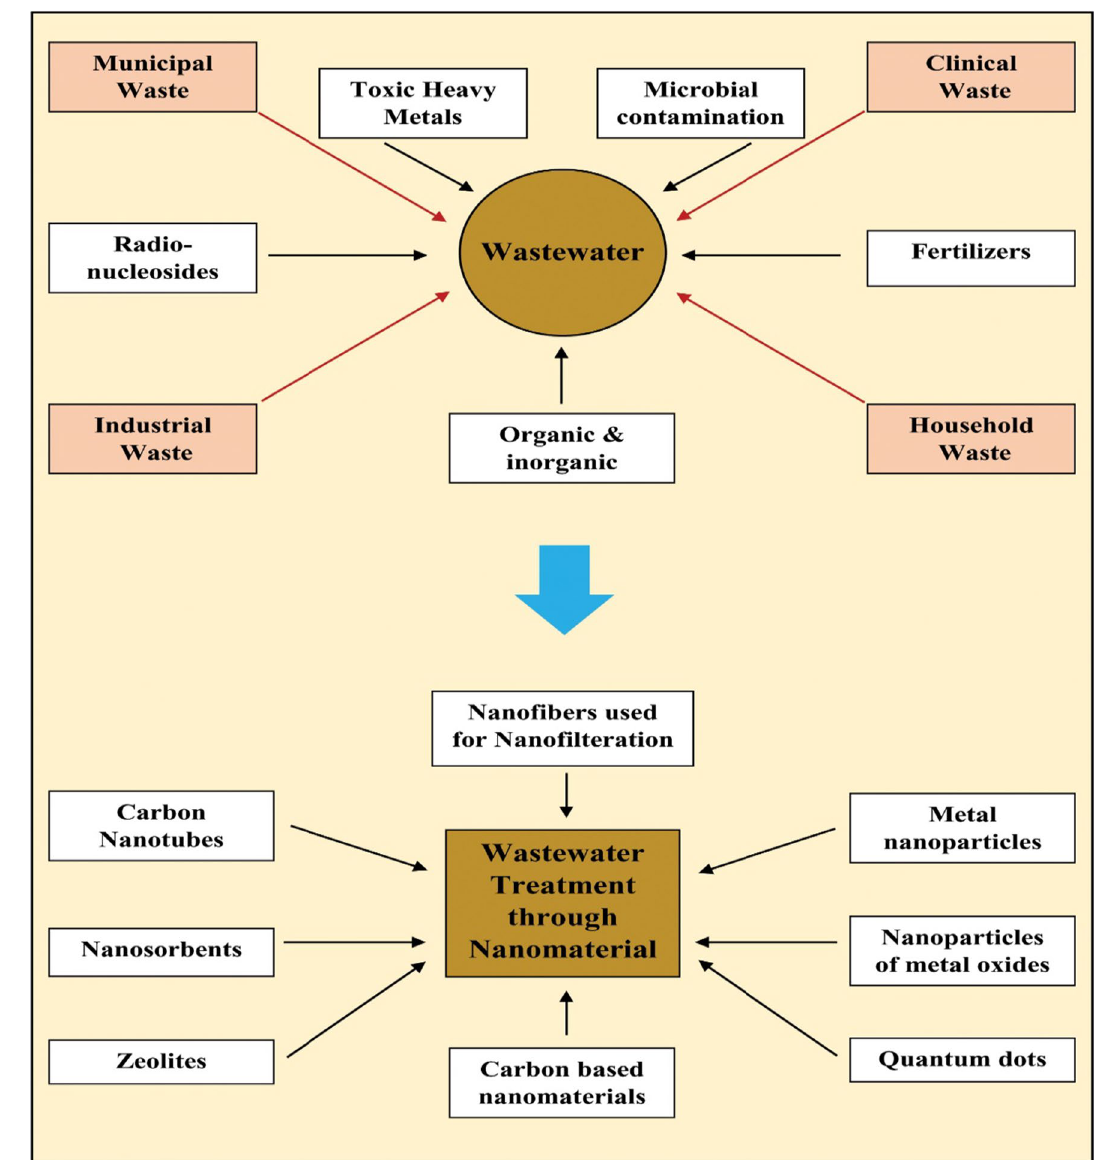
Fig. 1 Schematic representation of wastewater sources and their treatment through different